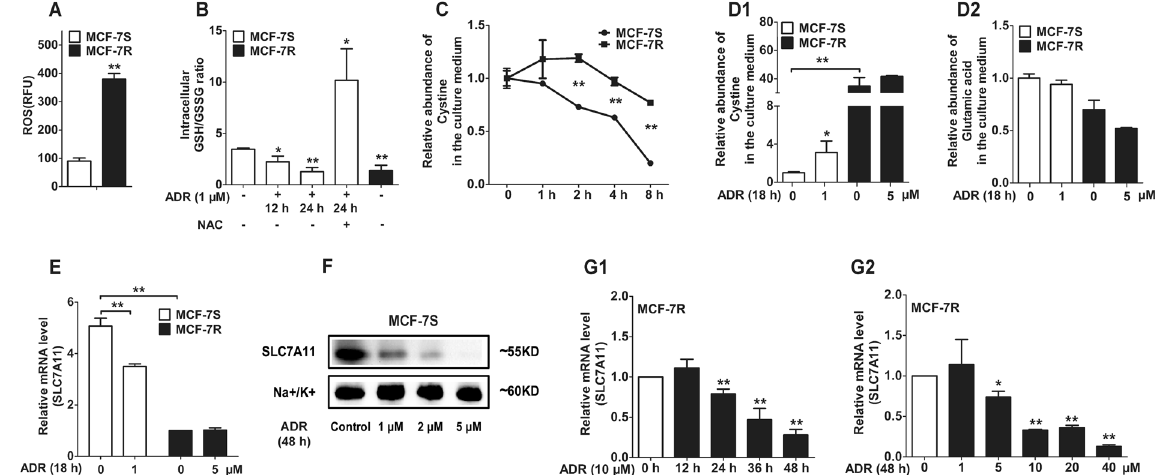
Figure 1. The differential impact of ADR on GSH/GSSG ratio, the influx of cystine and the expression of SLC7A11 in MCF-7S and MCF-7R cells. ( A ) The baseline ROS level in MCF-7R cells was remarkably higher than in MCF-7S cells. ( B ) ADR reduced the intracellular GSH/GSSG ratio in MCF-7S cells to a comparable level to that of MCF-7R cells, which was reversed by NAC (10 mM, 30 min of pretreatment). ( C ) The utilization of cystine was much higher in the culture medium of MCF-7S cells than that of MCF-7R cells, although both groups were treated with the same initial concentration (1.0 mM). ( D ) ADR inhibited the influx of cystine and the efflux of glutamic acid (substrates of SLC7A11) in MCF-7S (1 μ M) and MCF-7R (5 μ M) cells. ( E ) The SLC7A11 mRNA level in MCF-7R cells was intrinsically lower than in MCF-7S cells. Moreover, ADR markedly inhibited SLC7A11 mRNA expression in MCF-7S cells (1 μ M), but showed a marginal effect on MCF-7R cells (5 μ M). ( F ) ADR down-regulated SLC7A11 protein expression in MCF-7S cells. ( G ) The inhibitiory effect of ADR on SLC7A11 mRNA expression showed time-dependence and concentration-dependence in MCF-7R cells. All of the experiments were conducted in triplicate, and data with error bars are presented as the mean ± SD (n = 3). * p < 0.05; ** p < 0.01 vs.